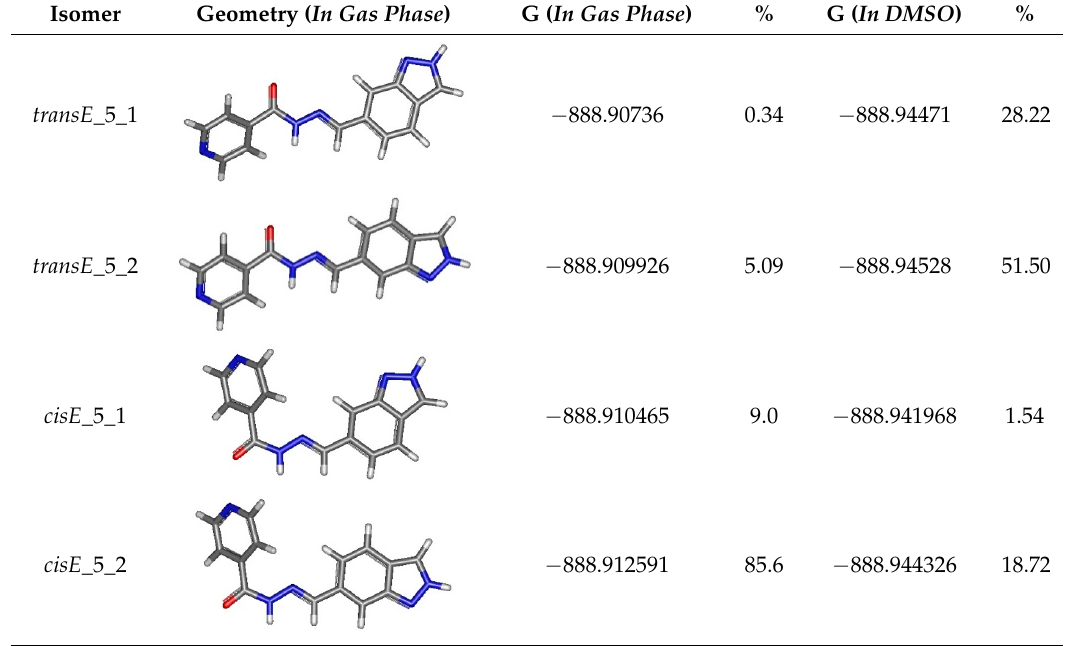
Table 3. Geometries, Gibbs free energies and Boltzmann distribution of the four major conformers of 5 at the B3LYP/6-31+G(d,p) in the gas phase and in the DMSO continuum solvent model (SMD). Isomer Geometry ( In Gas Phase )